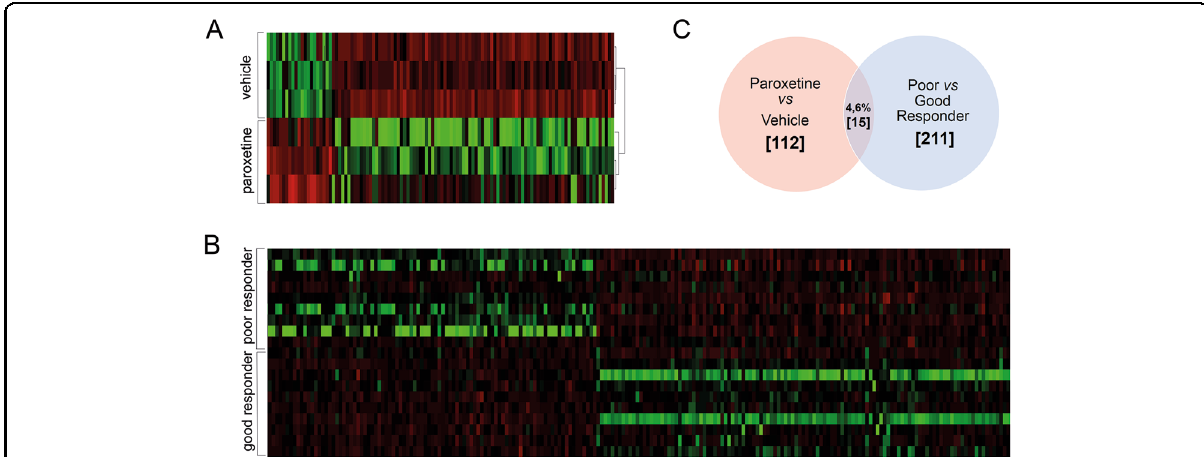
Fig. 2 Effects of paroxetine treatment on dentate gyrus transcriptome pro fi les. A Heatmap illustrating the impact of paroxetine treatment in comparison to vehicle administration (control). In a 3 vs 3 comparison of murine dentate gyrus transcriptome pro fi les, we found 112 differentially expressed genes (DEseq: Normcount > 2.68 (avg), padj < 0.05, FC > 1.5 fold). B Dentate gyrus transcriptome pro fi les of good and poor responders: when comparing RNA extracted from dentate gryus of good vs poor responder mice, we identi fi ed 211 differentially expressed genes (DEseq: Normcount > 2.68 (avg), padj < 0.05, FC > 1.5 fold). C Overlap between treatment- and response-associated differentially expressed genes: we compared treatment- and response-associated differentially expressed genes and found only 15 (4.6%) of them to be differentially expressed in both comparisons. [ X ] indicates the number of differentially expressed genes in the respective comparisons in the Venn